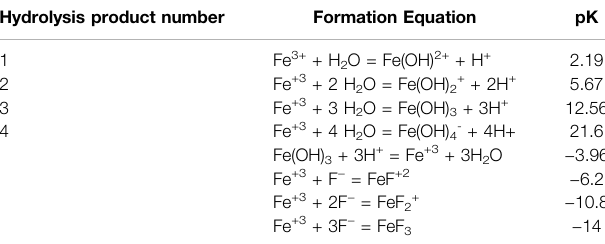
TABLE 5 | Speciation and solubility constants for iron species (data from Parkhurst and Appelo,